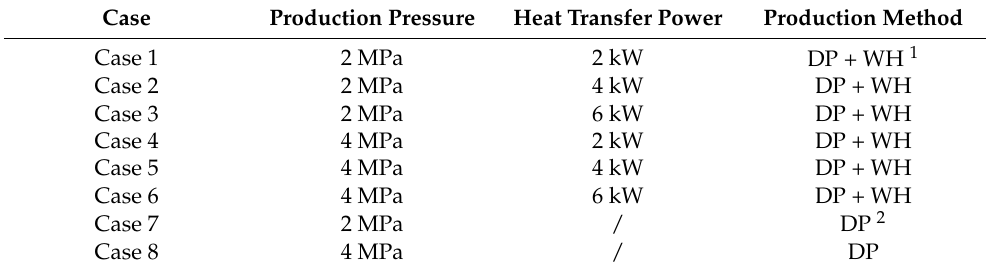
Figure 8. The heat transfer efficiency of the HTD: ( a ) the relationship between q , r, and Δ T ; ( b ) the relationship between q , z , and Δ T . Table 2. Production parameters for different